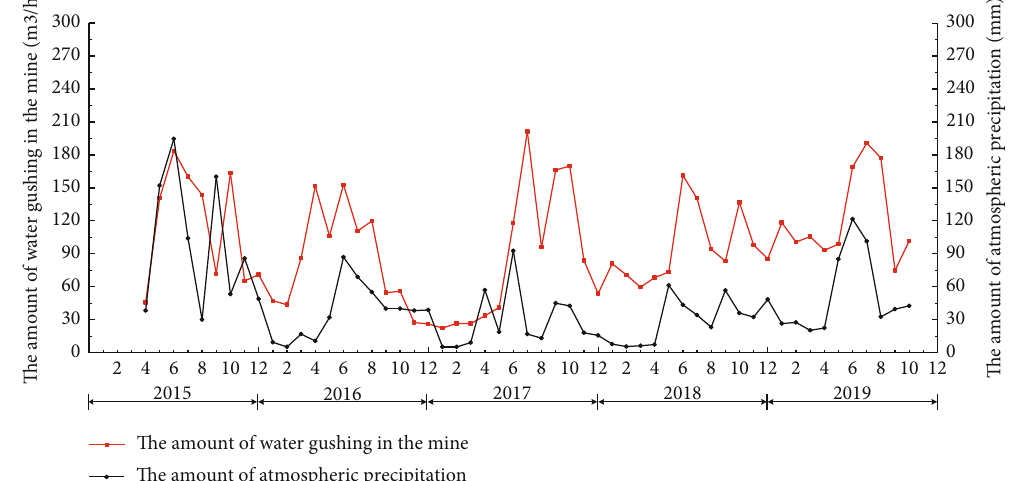
Figure 7: The relationship between mine water in fl ow and atmospheric rainfall in Xintian Mine.